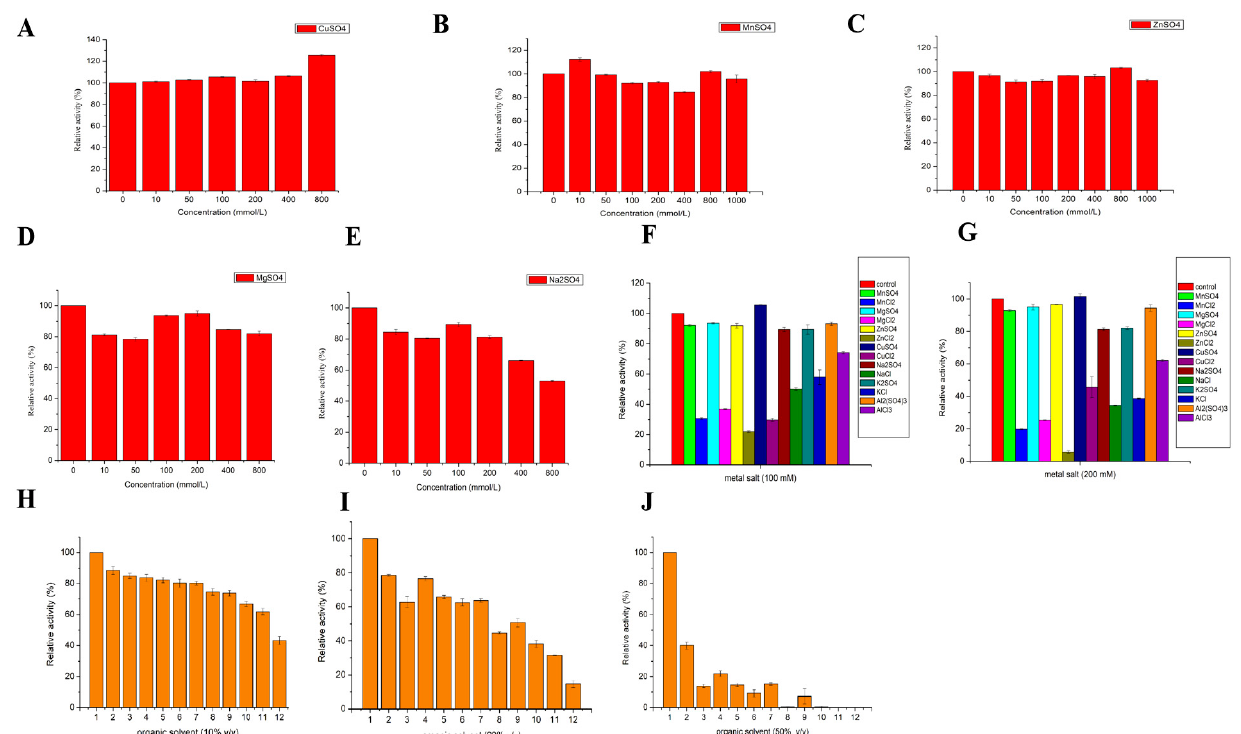
Figure 3. Effects of different metal ions and organic solvents on the LAC-4 laccase activity. ( A ) CuSO 4 , ( B ) MnSO 4 , ( C ) ZnSO 4 , ( D ) MgSO 4 , ( E ) Na 2 SO 4 , ( F ) Comparison of the effects of the metal salt with chloride as the anion and the sulfate ions as the anion on LAC-4 laccase activity (the concentration of metal salt was 100 mM), ( G ) Comparison of the effects of the metal salt with chloride as the anion and the sulfate ions as the anion on LAC-4 laccase activity (the concentration of metal salt was 200 mM), ( H ) Concentration of organic solvent was 10% ( v / v ), ( I ) Concentration of organic solvent was 20% ( v / v ), ( J ) Concentration of organic solvent was 50% ( v / v ). ( H – J ): 1: Control, no addition